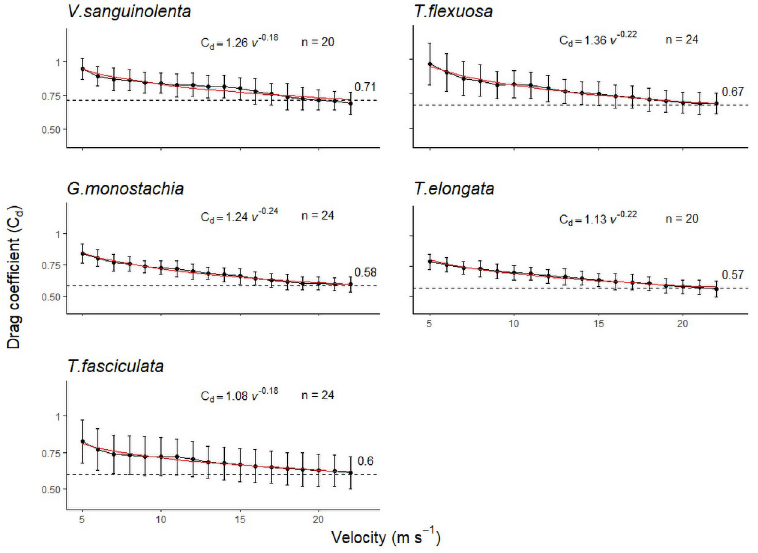
Fig 3. Variations in C values over increasing wind speeds. Filled circles are mean velocity-specific C d values of all d tested individuals within each species and error bars depict standard deviations. Red lines show the fitted function C d (v). Dashed lines indicate the mean C d value of each species, which plateaued over the higher wind speeds at 20–22 m s -1 . A lower C d indicates a more streamlined shape for less aerodynamic